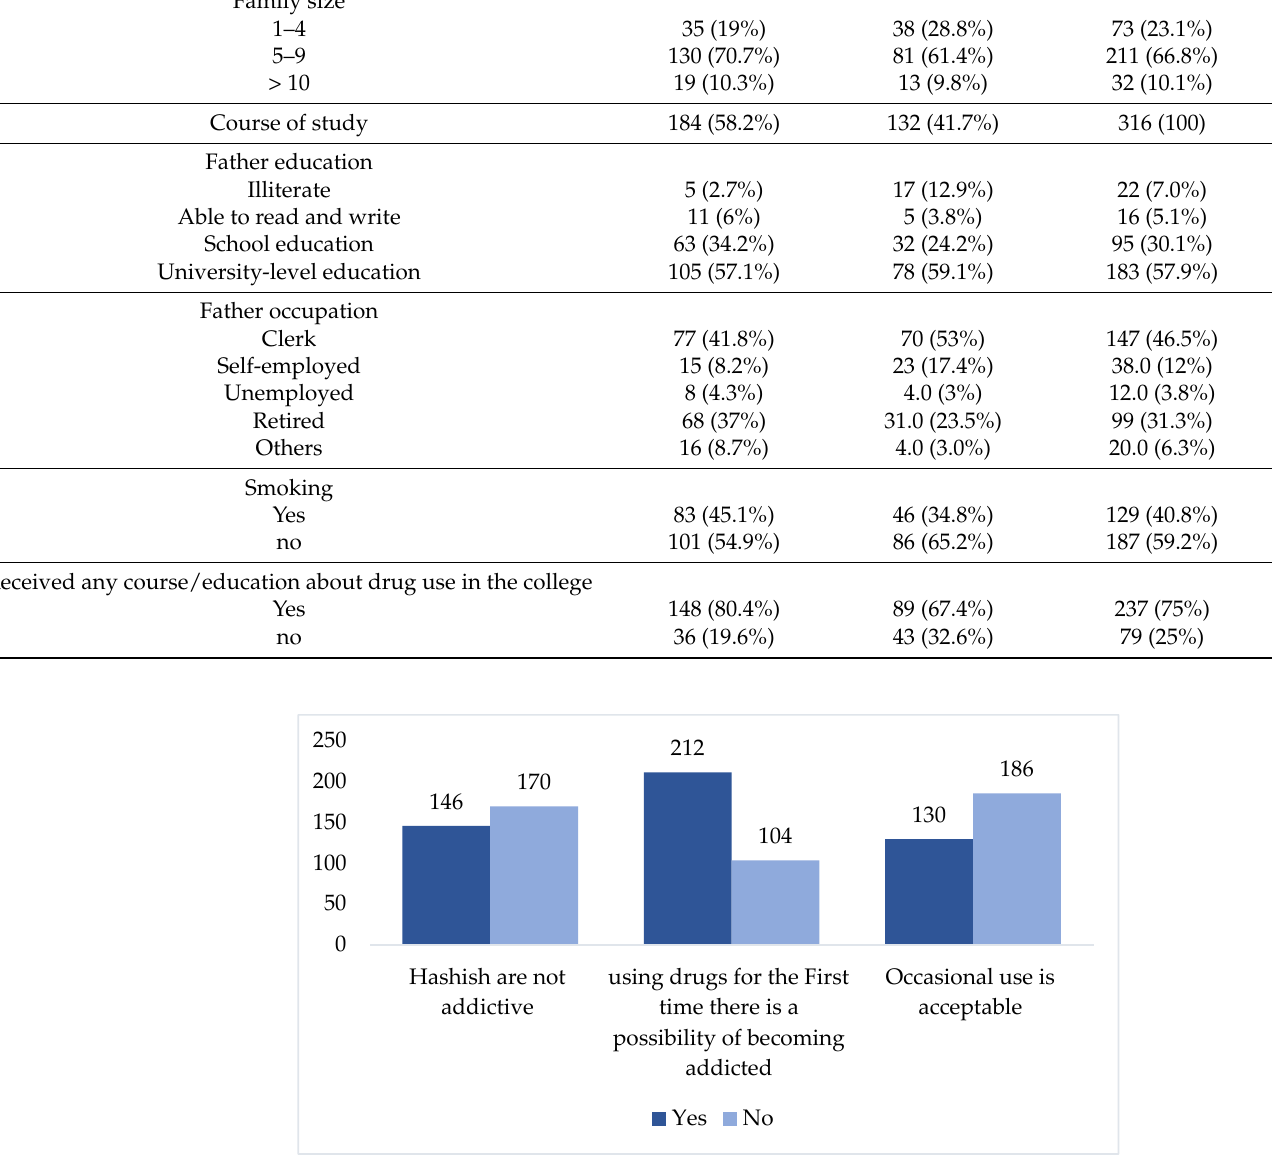
Figure 2. Opinions/views of students about addictive drugs. Table 4. Association between attitude score and student’s characteristics.